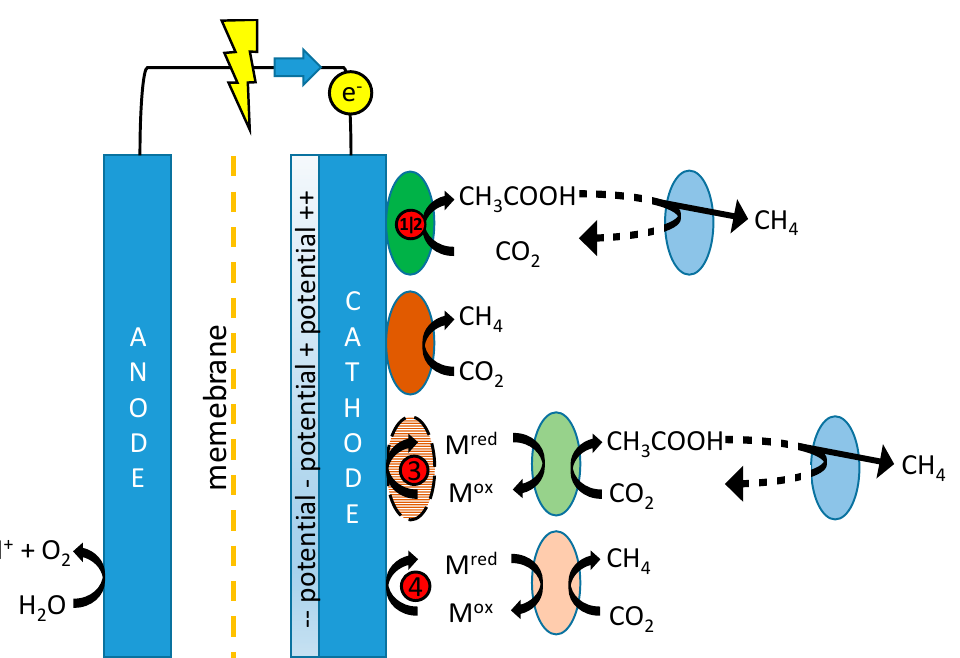
Figure 1. Different metabolic pathways in a mixed-culture biocathode as proposed in different studies. A distinction can be made between direct electron transfer [18], in which microbes are directly attached to the electrode surface, thus allowing electrons to reach the intracellular environment by means of electrical conductance, and the use of a redox active chemical mediator (M ox /M red ) in the case of indirect electron transfer. Several studies have suggested a combination, in which direct electron transfer leads to the biocatalysed reduction of a mediator compound, which then functions as electron donor for suspended cultures [7,8]. Regardless of whether initial electron transfer takes place directly or indirectly, close competition between methanogens ( brown ) and acetogens ( green ) will exist for available electrons. Regarding the composition of a possible mediator, although in theory any kind of mediator could be shuttling electrons back and forth between electrode and microbe as long as its reversible redox potential is adequate, in practice this role is most likely fulfilled by hydrogen, although formate has been hypothesized to play a role as secondary mediator as well [1]. Any formed acetate can be further oxidized acetoclastically to form CO 2 and methane ( blue microbe ). The red-circled numbers refer to the potential levels tested in this study, aimed at establishing indicated pathways and are further defined in the materials and methods section.